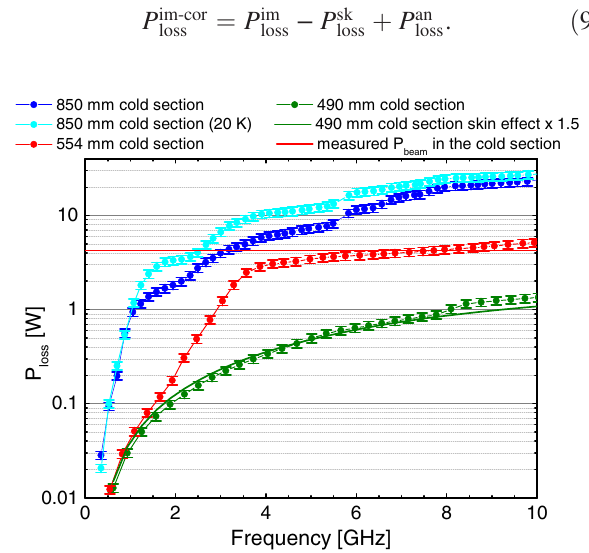
FIG. 16. The power lost by the electron beam up to the measured frequency f using the impedance in Fig. 15, assuming the same beam properties as for the measured beam heat load P in the cold section (red solid line): 300 mA average beam beam current with 900 bunches and a bunch length of 14.5 ps.